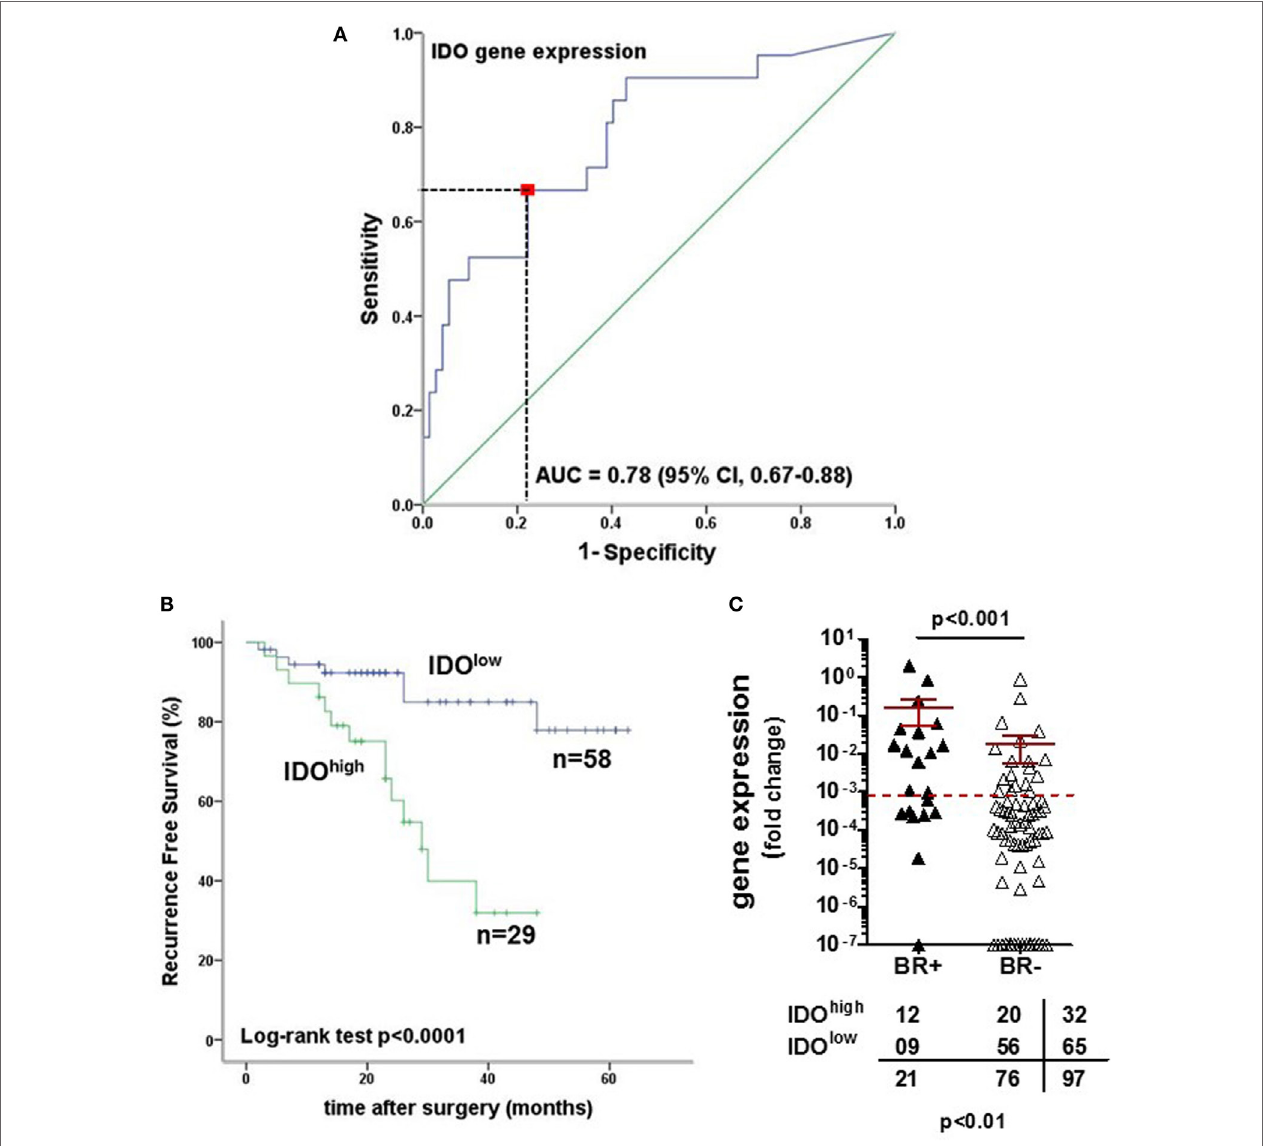
FigUre 6 | Indoleamine 2,3-dioxygenase (IDO) tumor-specific expression is a strong prognostic factor for biochemical recurrence (BR) in prostate cancer (PCa). (a) Receiver operating characteristic (ROC) curve analysis was used to evaluate the prognostic relevance of IDO gene expression. The area under the curve for recurrence-free survival (RFS) was 0.78 (95% CI, 0.67–0.88%) with an optimal cutoff level of 9.83 × 10 − 4 to dichotomize the patients into IDO high and IDO low groups (specificity 78%, sensitivity 67%). (B) Kaplan–Meier estimates of RFS stratified by the established cutoff for IDO gene expression in PCa tissue specimens (IDO 9.83 × 10 − 4 ). The survival analysis was based on time of BR (RFS with a median survival of 29 months; 95% CI, 22–36%; p < 0.0001, two-sided log rank test). (c) IDO gene expression in PCa tissue specimens was higher in BR-positive than in BR-negative patients ( p < 0.001, Mann–Whitney U test), with a clear association between IDO gene levels and evidence of BR (prostate-specific antigen ≥ 0.1 ng/ml) (Pearson χ 2